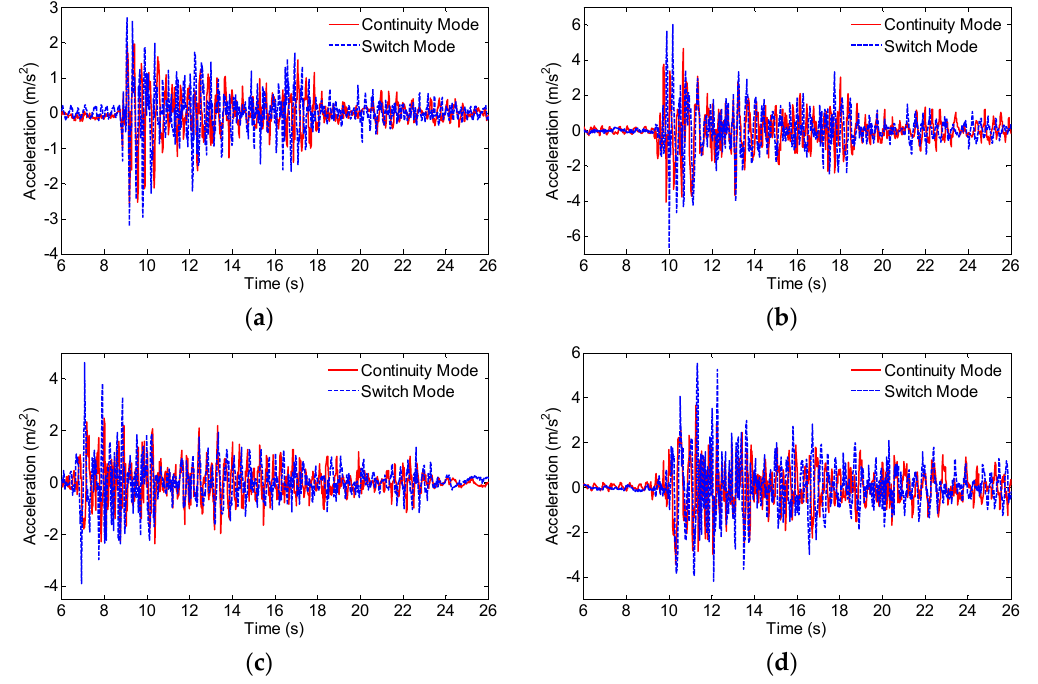
Figure 10. Acceleration time history of the fifth floor under continuity and switch modes: ( a ) El Centro wave under fortification intensity; ( b ) El Centro wave under rare intensity; ( c ) Taft wave under fortification intensity; ( d ) Taft wave under rare intensity.